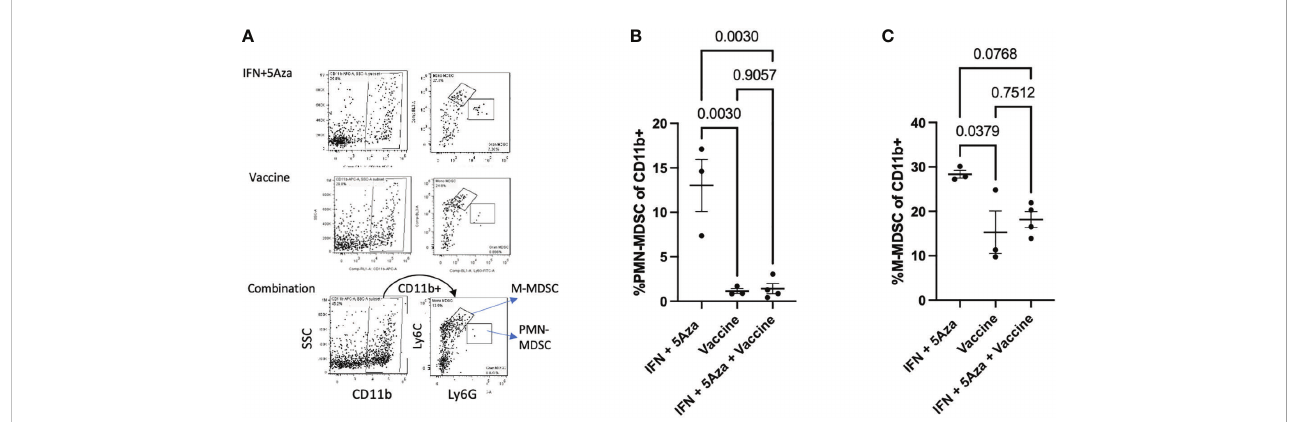
FIGURE 4 MDSC analysis. (A) Gating structure. Cells were selected as CD11b+ and then divided into PMN-MDSCs (Ly6G hi/Ly6C lo) and G-MDSCs (Ly6C hi, Ly6G lo). Plots shown are representative samples from their groups. (B, C) Grouped analysis as a percentage of CD11b+ cells of (B) PMN-MDSCs and (C) M-MDSCs. Data are representative of one experiment with 3-4 mice per group and are tested by by One-Way Anova with Tukey ’ s multiple comparisons